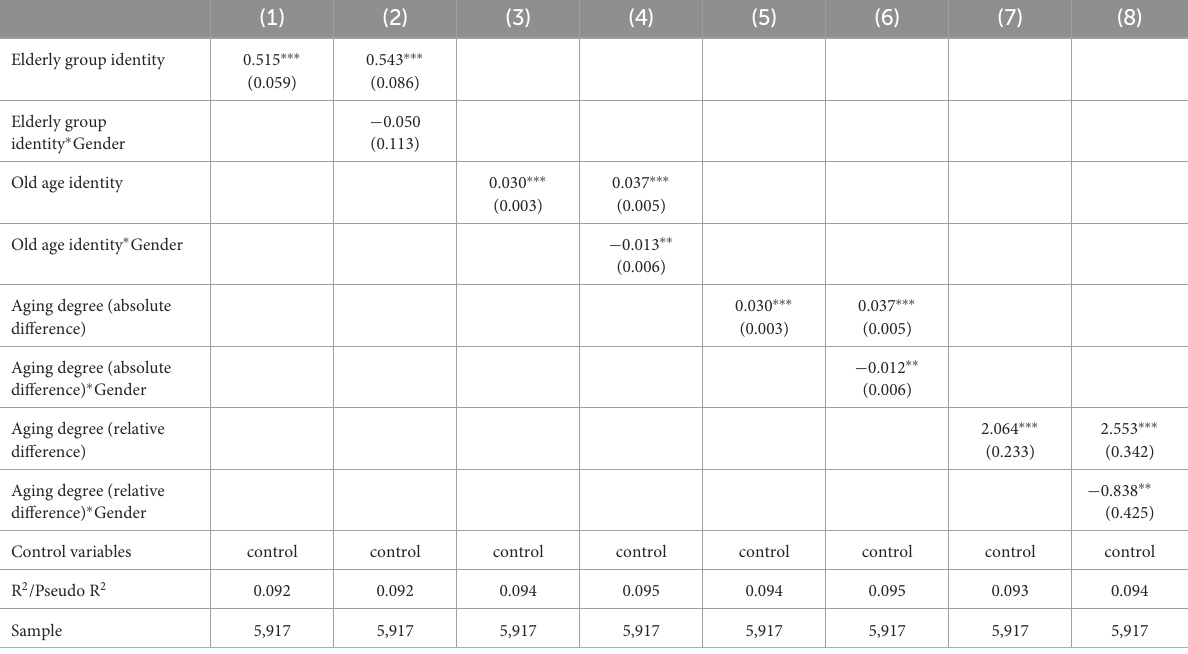
TABLE 4 The self-enhancement effect of old age identity among the Chinese